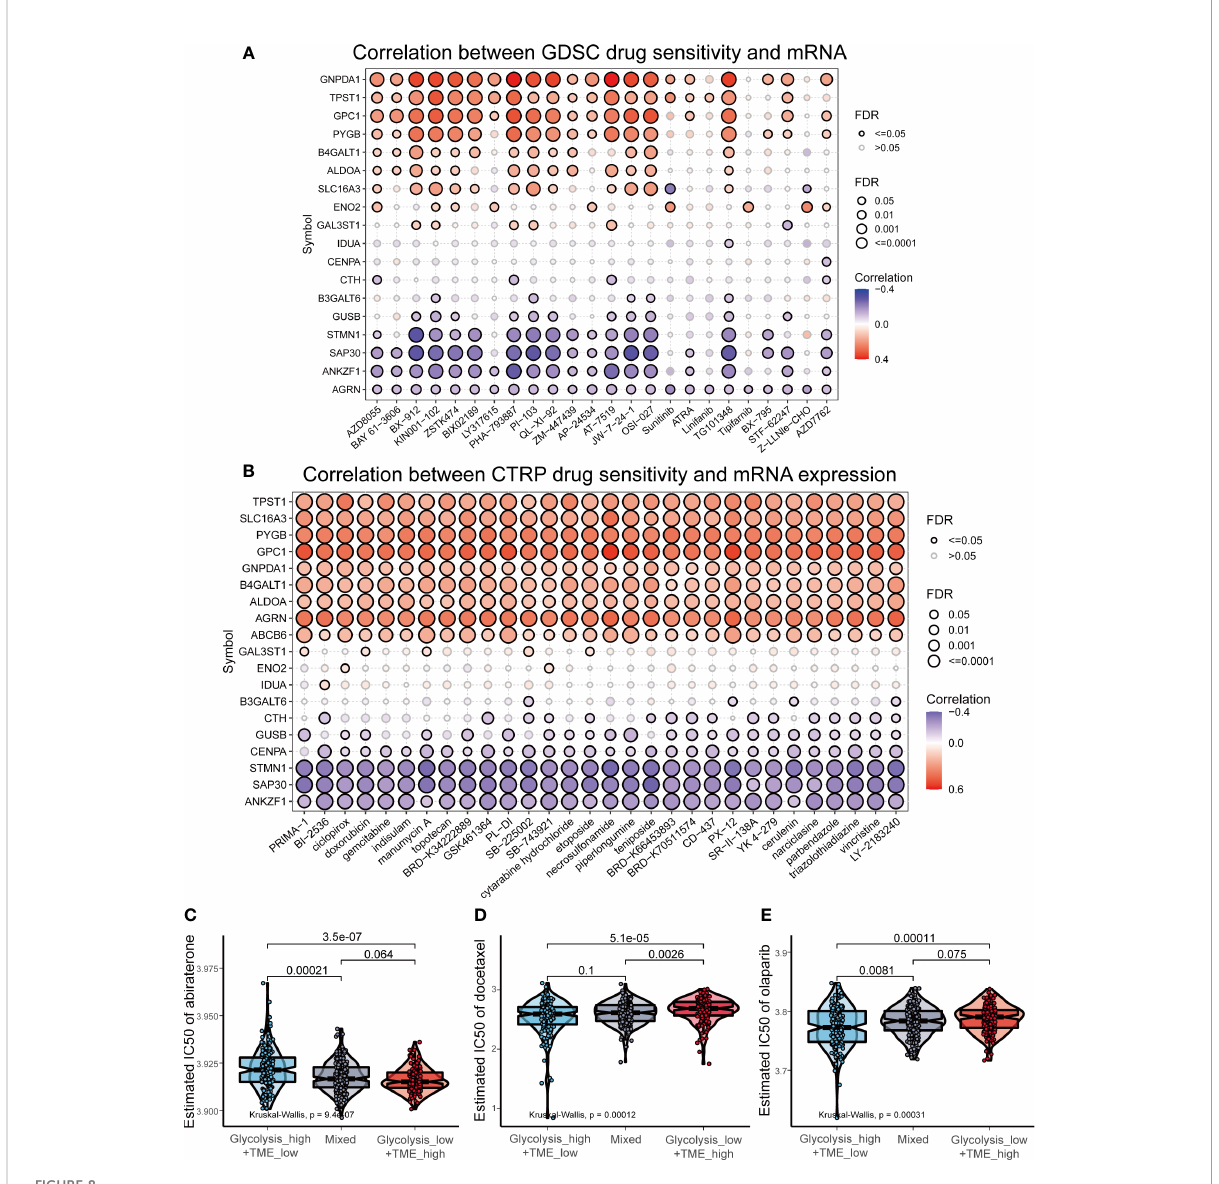
FIGURE 8 Drug sensitivity analysis in prostate cancer. (A, B) The correlation between drug sensitivity and expression of GRGs based on Genomics of Drug Sensitivity in Cancer (GDSC) and Cancer Therapeutics Response Portal (CTRP) datasets. (C-E) The comparison of the estimated IC50 of abiraterone, docetaxel and